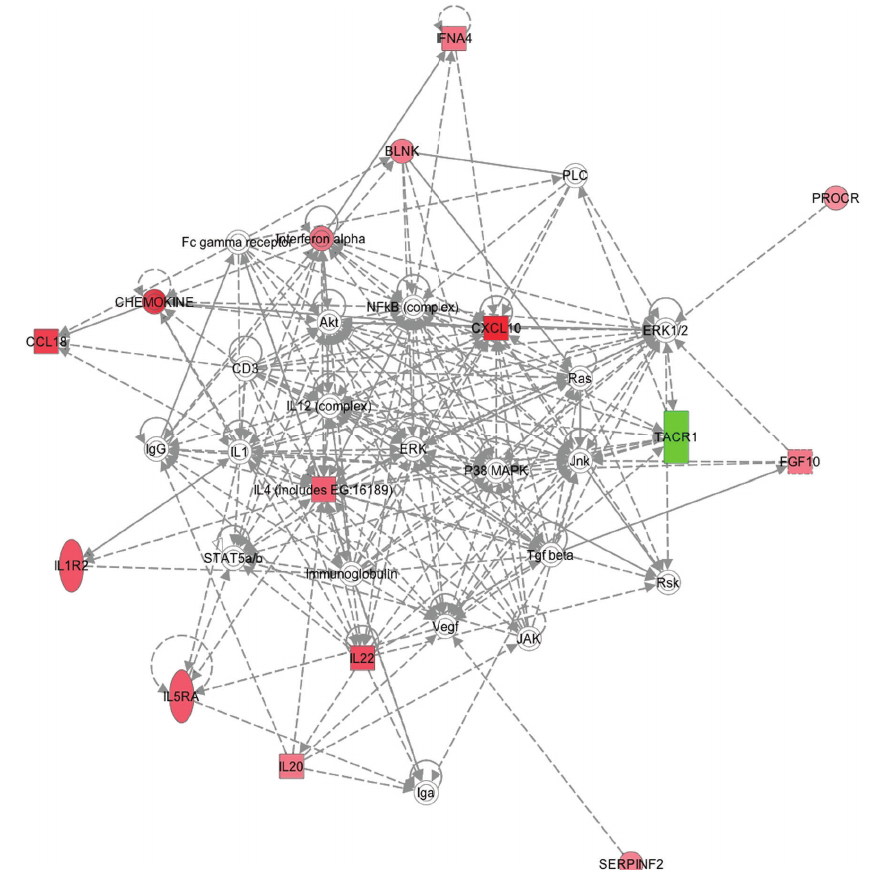
Figure 3: Ingenuity Pathway Analysis of altered expression of proinflammatory genes in normal human melanocytes transduced with Ad- Slug. Expression levels were determined using the PAHS-3803 Human Inflammatory Response and Autoimmunity Cytokine Array (SA Biosciences), and genes with expression altered more than two-fold in duplicate assays were included in the Ingenuity Pathway